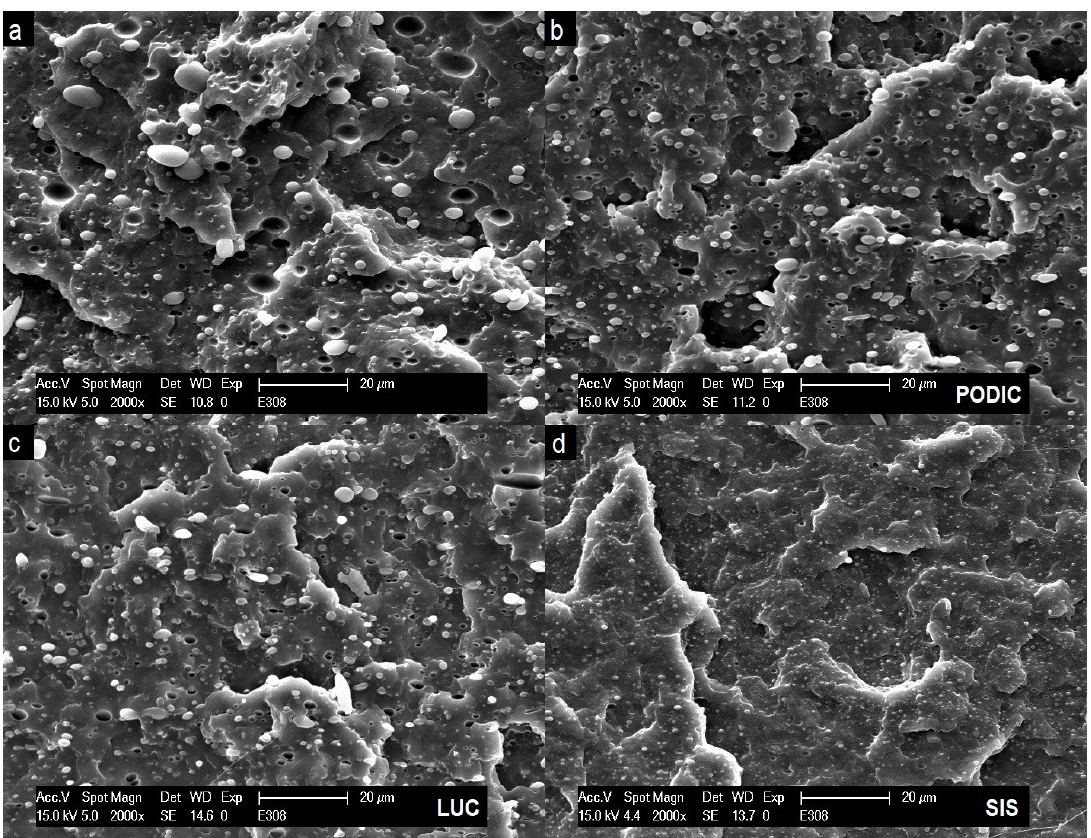
Figure 9. SEM images of PP–PS 90:10 blends: uncompatibilized ( a ), PODIC ( b ), LUC ( c ), SIS ( d ). .